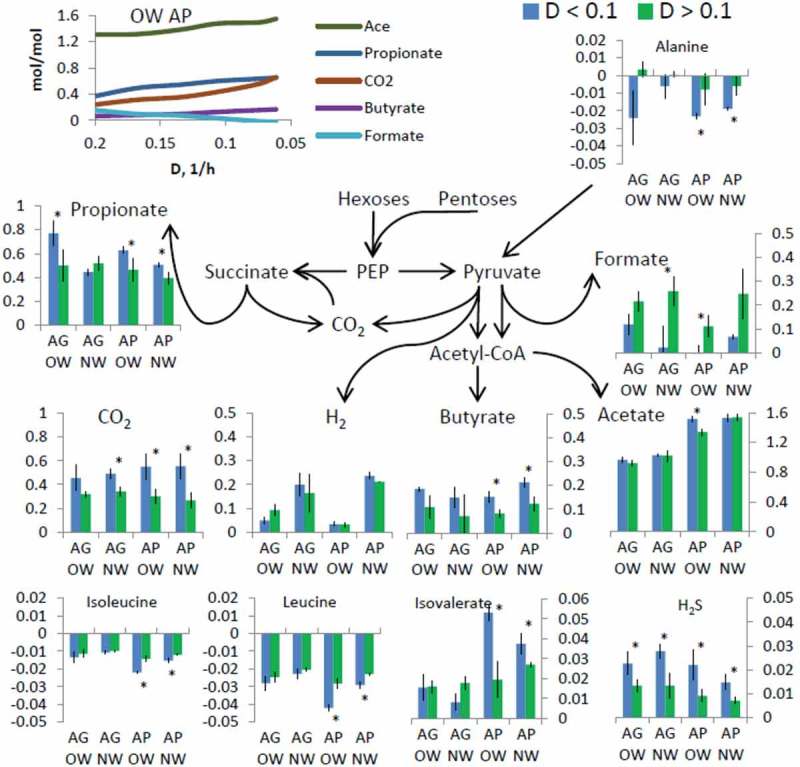
Production of organic acids and gases and consumption of amino acids per carbohydrates consumed (molar yields, all sub-figures have x-axis unit mol/mol) in De-stat cultures with pooled fecal inocula of children. On the top left figure, the metabolic products during the decrease of dilution rate from 0.2 to 0.06 1/h, are shown in experiment of OW fecal pool and AP mucin medium as an example. In the other plots average values of productions or consumptions at high (>0.1 1/h) or low (<0.1 1/h) dilution rates are shown for all experiments. Metabolic scheme illustrates overall picture without cross-feeding possibilities between different bacteria. OW – pooled fecal samples of the overweight children, NW – pooled fecal samples of the normal weight children, AG – arabinogalactan, AP – apple pectin, ace – acetic acid, but – butyric acid, for – formic acid, ibut – isobutyric acid, lact – lactic acid, prop – propionic acid, succ – succinic acid, val – valeric acid. Mucin was present in all growth media. The blue bars depict the interval of the dilution rate from 0.06 to 0.1 1/h, and the green bars – dilution rate D from 0 0.1 to 0.2 1/h. Asterisks indicate p-value on single parametric t-test of molar yields between high and low dilution rates. Production and consumption rates of all metabolites (mmol/g/L) are given in Supplementary Table S2.